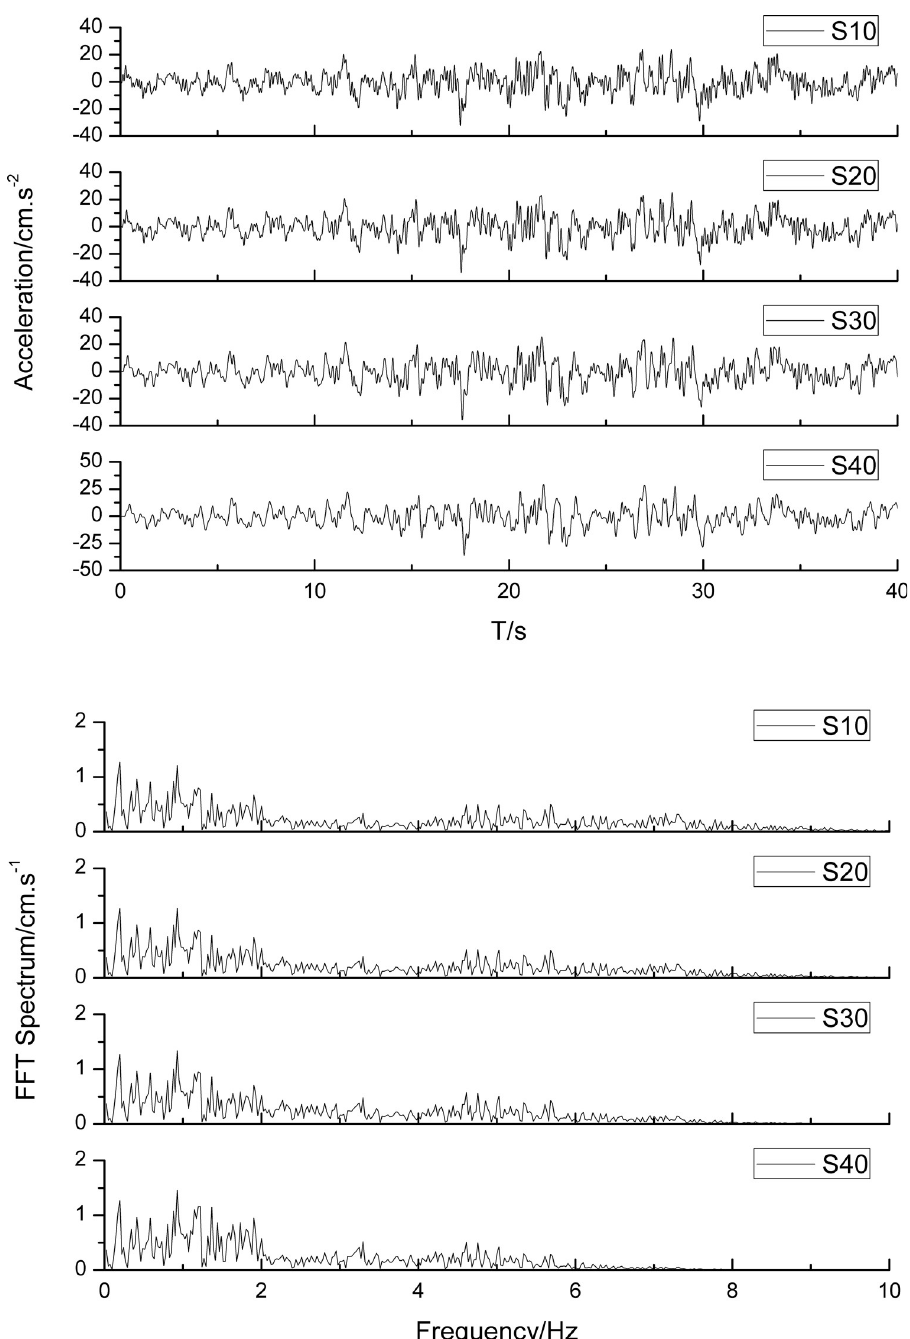
Fig 11. The acceleration time histories and the spectrum characteristics at the free surface. (a) the acceleration time histories; (b) the spectrum characteristics.